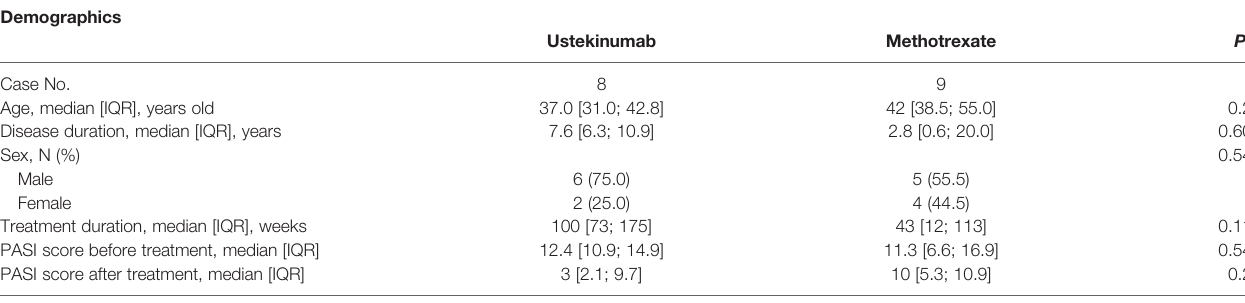
TABLE 1 | Demographics of ustekinumab- and methotrexate-treated psoriasis patients. Demographics